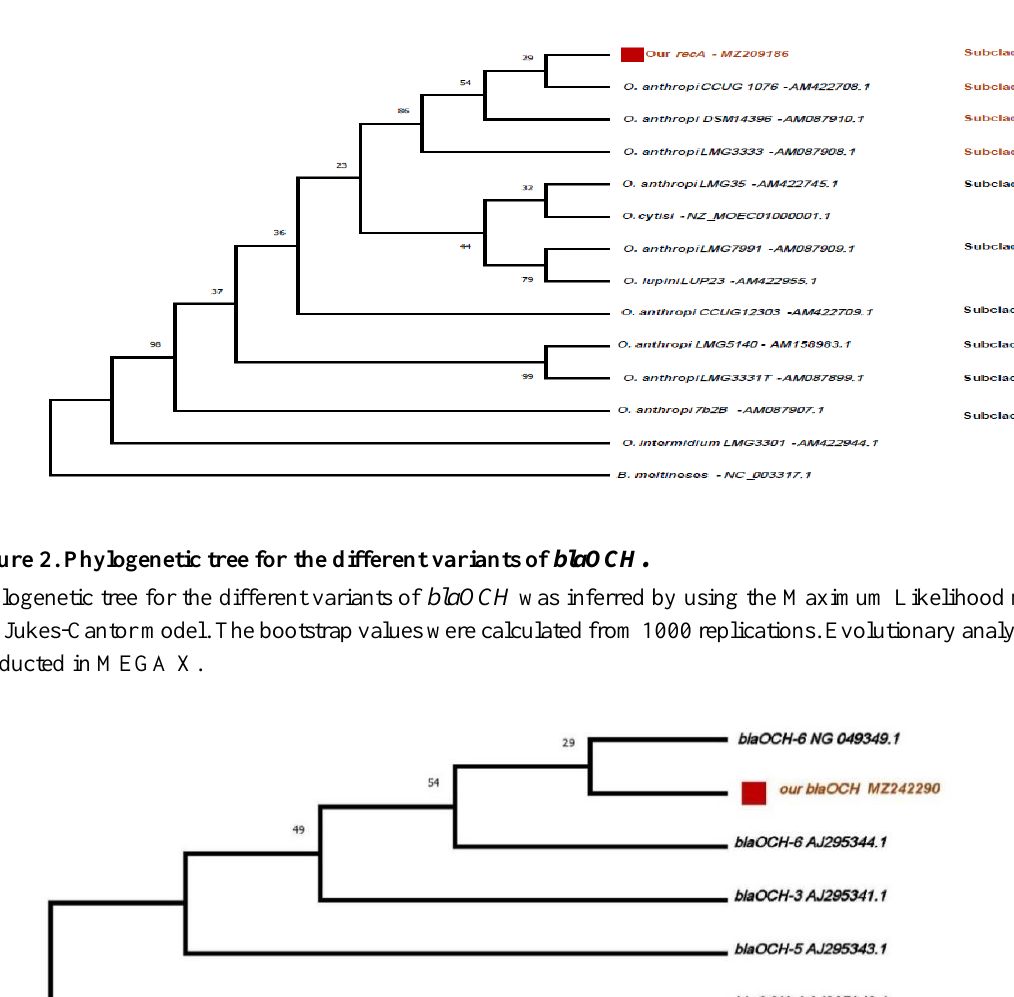
Figure 1. Phylogenetic tree based on recA sequence analysis.